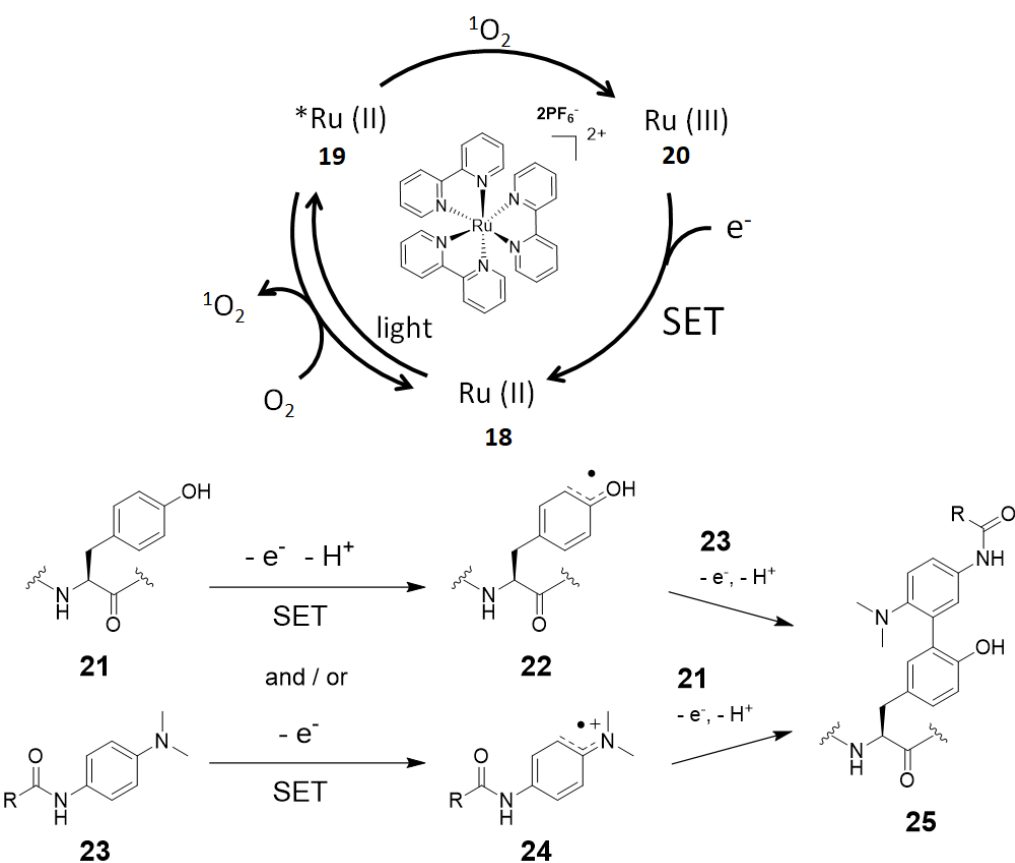
Figure 7. Proposed reaction mechanism for tyrosine labeling with ruthenium photocatalyst.